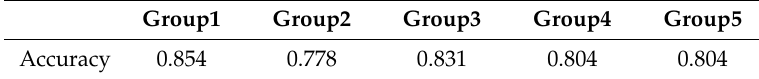
Table 6. Lab2 The accuracy of TrAdaboost algorithm on different Src groups.